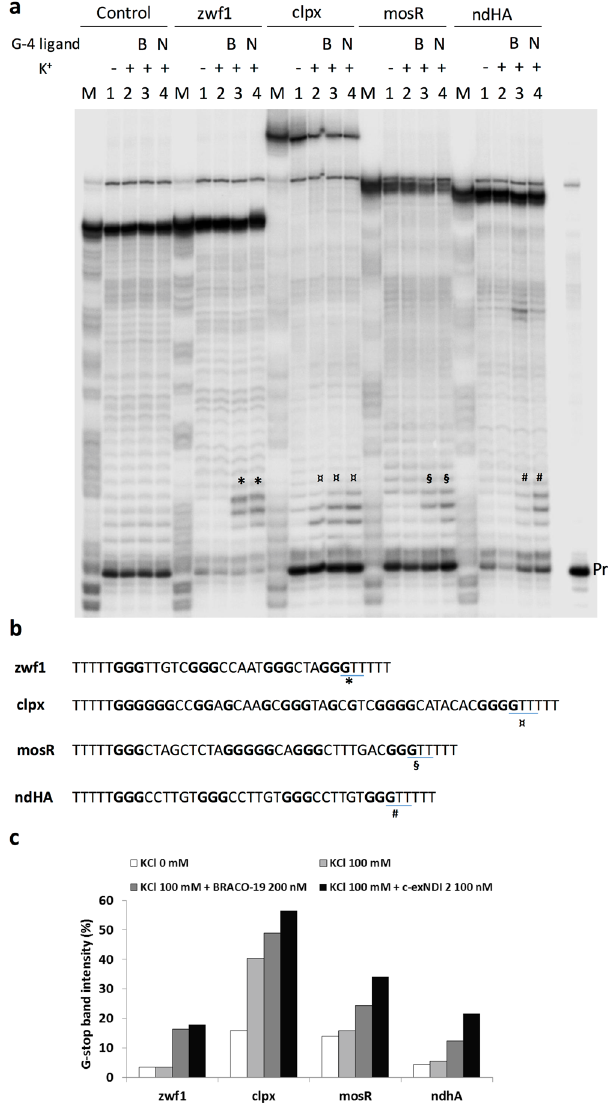
Figure 3. Taq polymerase stop assay. (a) Sequencing PAGE of Taq -amplified zwf1 , clpX , ndhA and mosR templates in the absence (lanes 1) or presence of 100 mM KCl (lanes 2) and G4 ligands BRACO-19 (lanes 3) or c-exNDI 2 (lanes 4). The control template is a sequence unable to fold in G4. Symbols * , ¤, § and # indicate pausing sites just before the G4 region of the templates. Pr indicates the band of the labeled primer. M is a marker lane obtained with the Maxam and Gilbert sequencing protocol. B and N indicate BRACO-19 and c-exNDI 2, respectively. (b) Sequences of the selected G4 oligonucleotides. The exact position of the pausing sites within the template G4 sequence is indicated by the symbols * , ¤, § and #, as shown also in ( a ). (c) Quantification of the intensity of the stop bands obtained in ( a